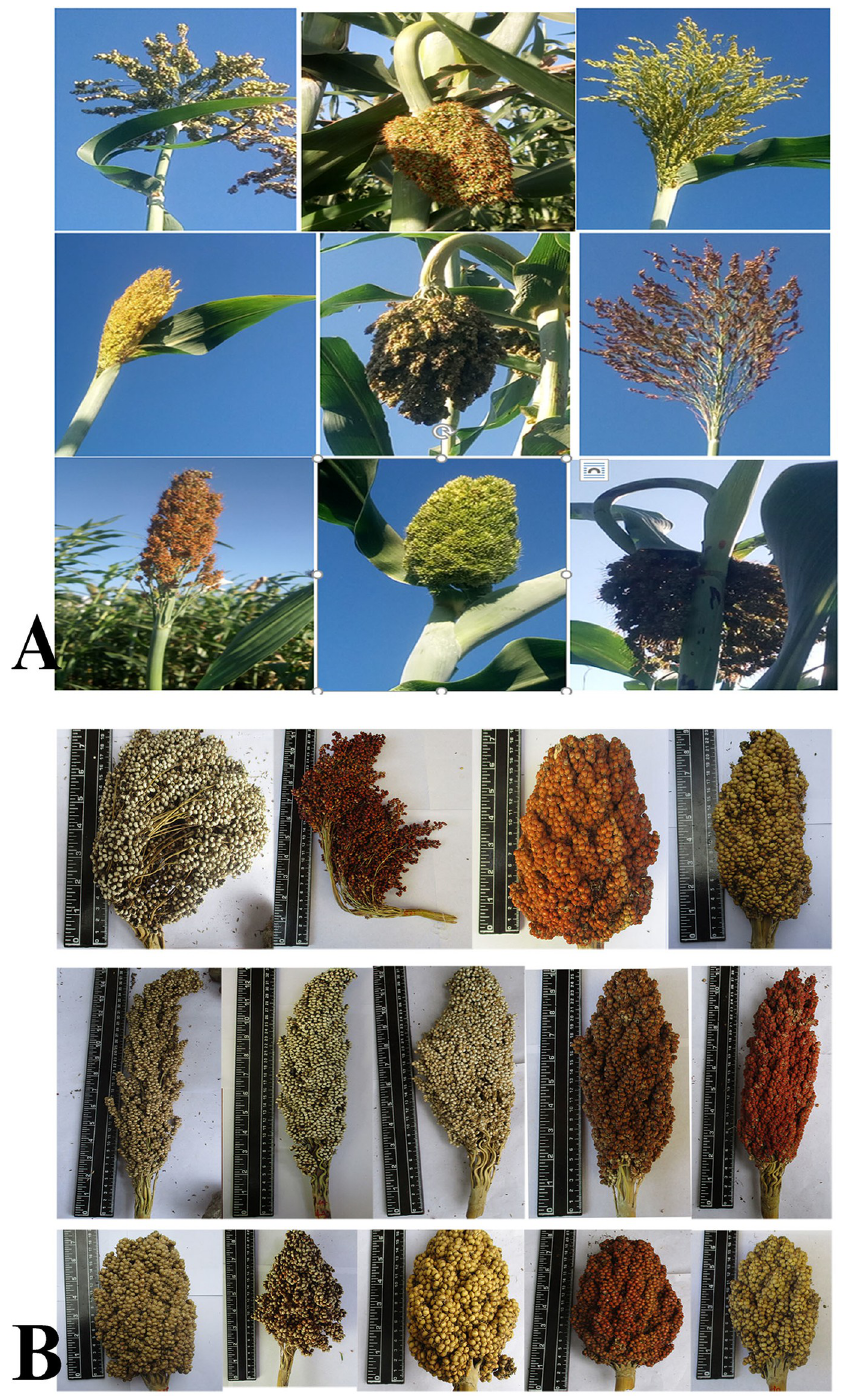
Fig 2. Diverse sorghum panicles A) at early grain filling and B) at